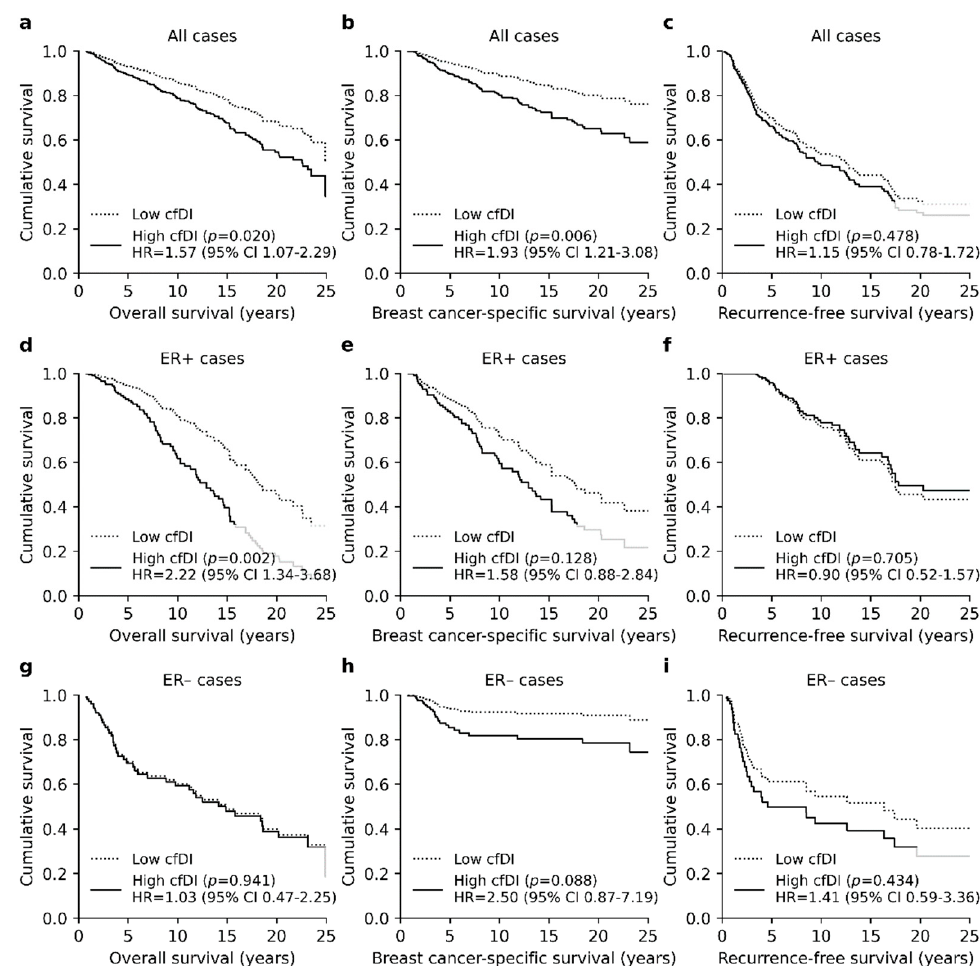
Figure 4. Cox regression analysis plots representing the association between high cfDI and BC survival. ( a ) High cfDI was an independent prognostic factor for poor OS ( p = 0.006) and ( b ) BCSS ( p = 0.020) but not for the ( c ) poor RFS ( p = 0.478). ( d – f ) Similar results were observed in ER+ patients although the only significant difference in survival was observed for OS. ( g – i ) In the ER − patients high cfDI was associated with poor BCSS but was not significant, whereas associations with OS and RFS remained less prominent. Grey lines represent the survival function of high cfDI group in areas where the plot overlaps with the